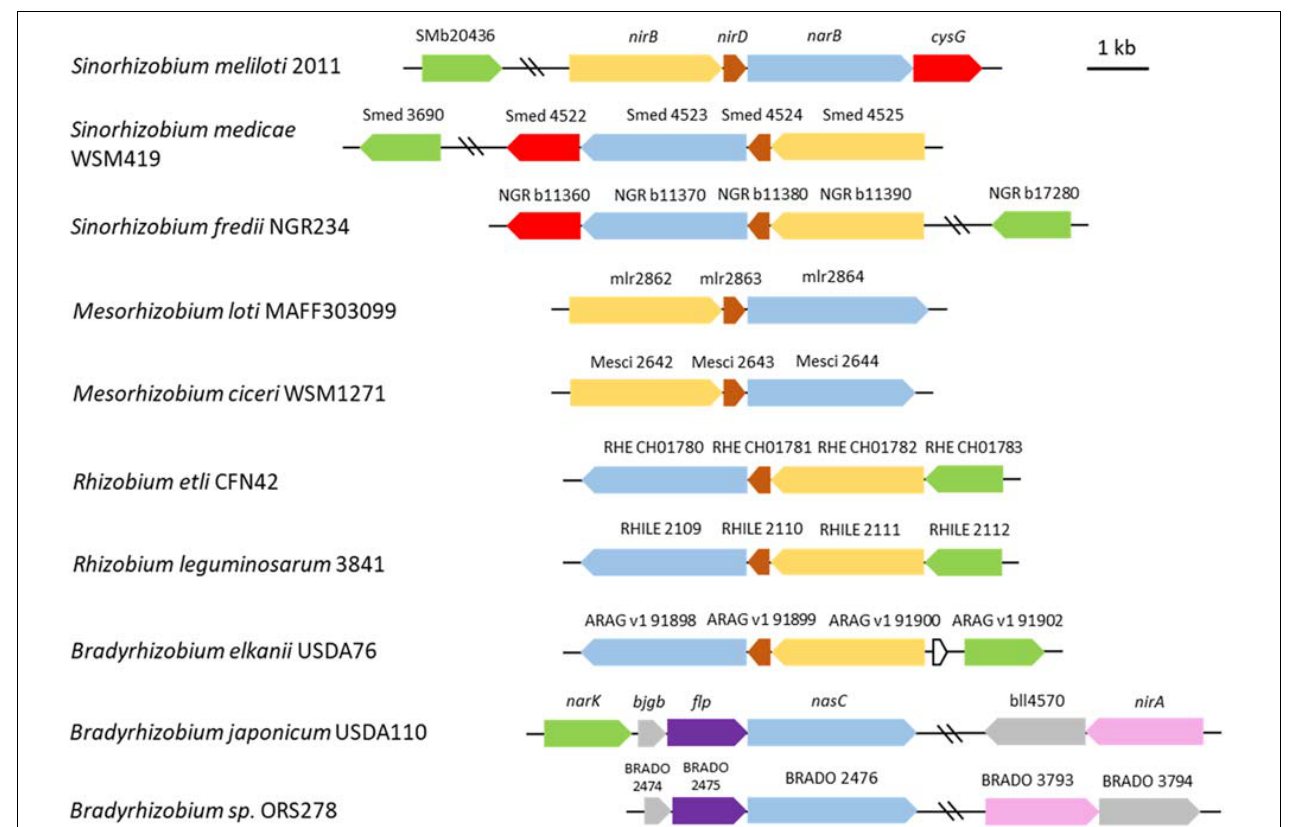
FIGURE 8 | Genomic arrangement of genes involved in nitrate assimilation in selected rhizobia. Genes encoding the assimilatory nitrate reductase (NarB) and nitrite reductase (NirB) in Sinorhizobium meliloti are colored in blue and yellow, respectively. Other genes are colored as follow: brown, nirD (encoding a small nitrite reductase subunit); green, SMb20436 (encoding the putative nitrite transporter); red, cysG (SMb20987) (encoding the putative protein involved in the synthesis of sirohaem, the nitrite reductase cofactor); purple, flp . Closest homologs (protein identity) found in other rhizobia are shown with the same color code. The assimilatory nitrite reductase NirA (pink) in Bradyrhizobium japonicum doesn’t display significant identity with NirB. The scheme was constructed based on data from the Microbial Genome Annotation & Analysis Platform MAGE (http://www.genoscope.cns.fr) database. The strains are listed according to their phylogenetic proximity from S.